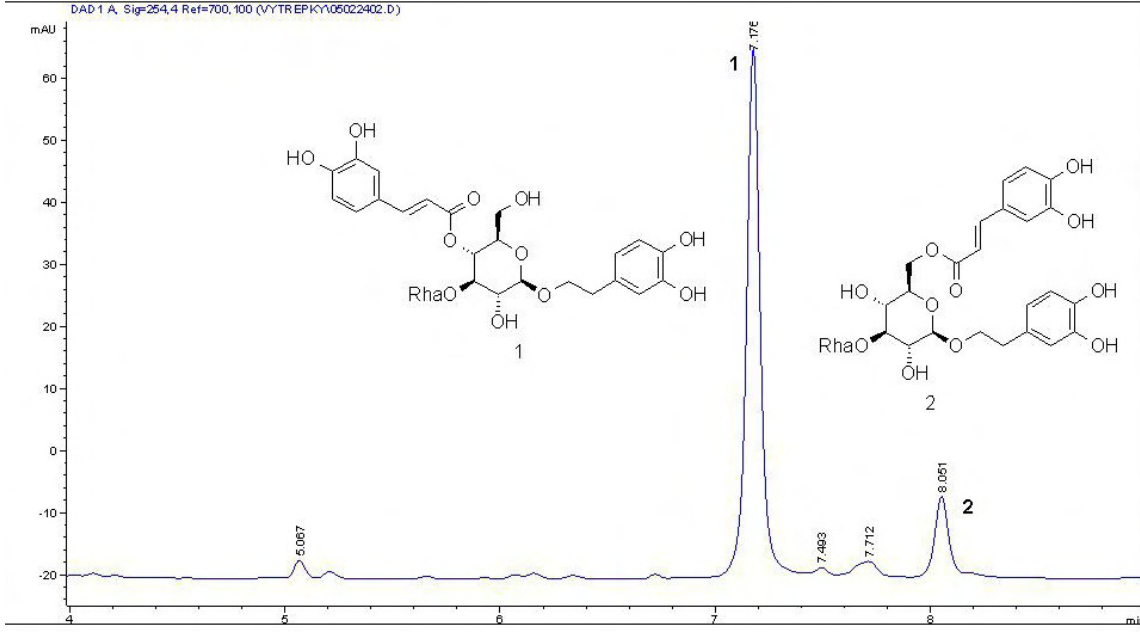
Figure 3 : HPLC chromatograms of the EtOAc extract of P. tomentosa fruits, 1 g L -1 (1 µL injection) showing acteoside ( 1 ) and isoacteoside ( 2 ).